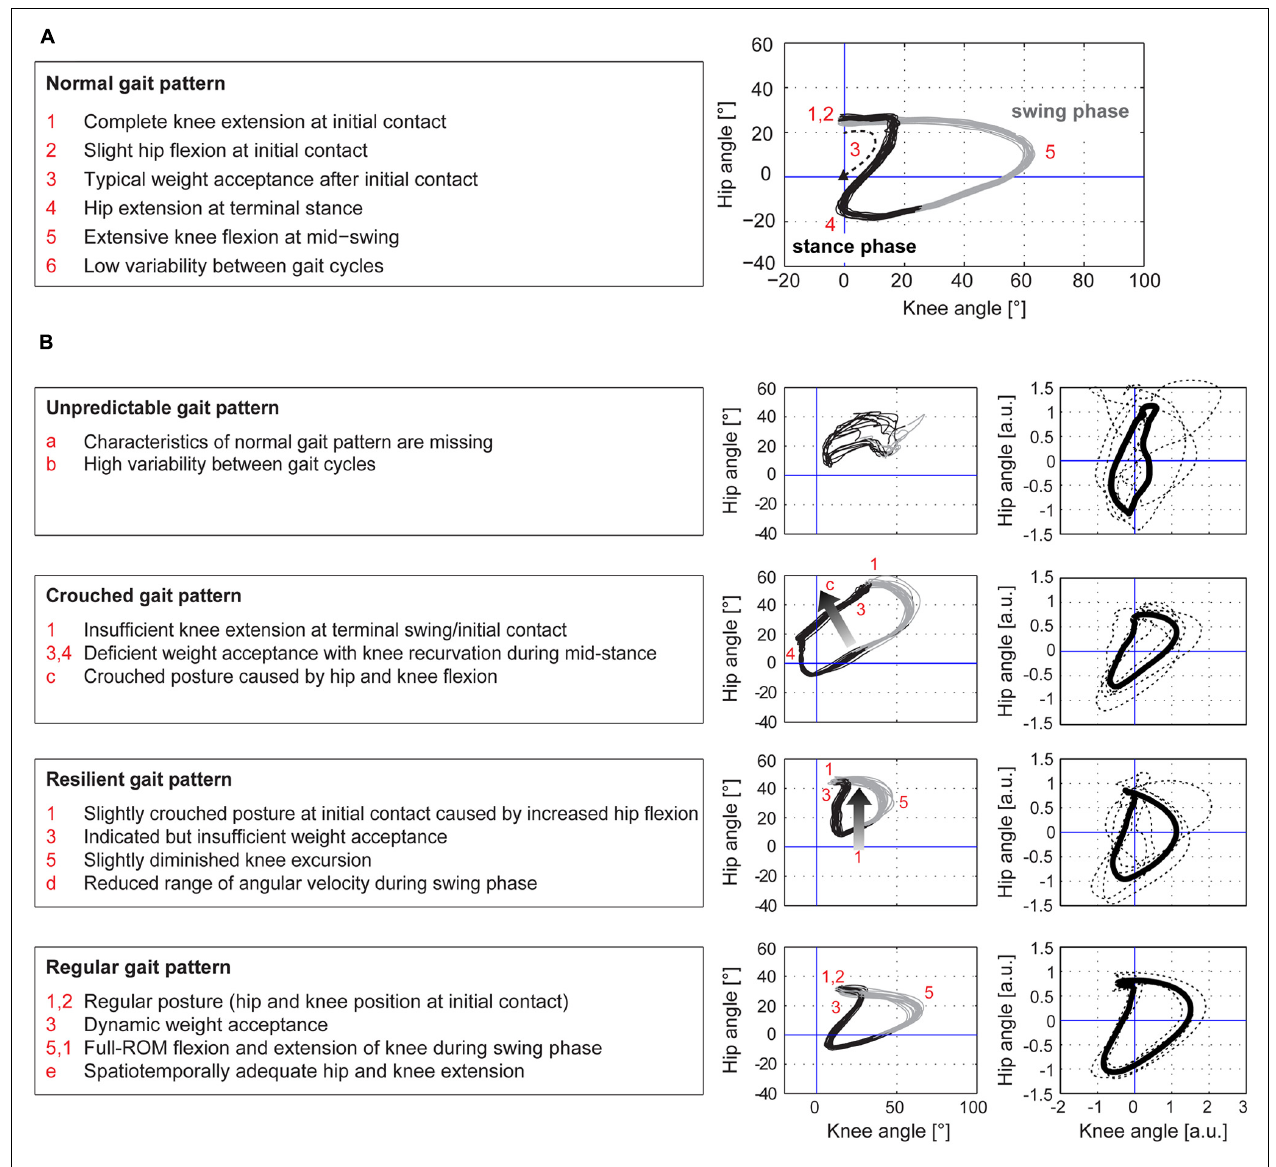
(B) .The criteria for each group are listed in the boxes on the left.The cyclograms in the left column show one representative example per group, the right column depicts the individual cyclograms of each iSCI subject within a group (dashed lines) and the group mean cyclogram (solid bold line) after translation of the cyclogram’s centroid to origin (zero) and uniform